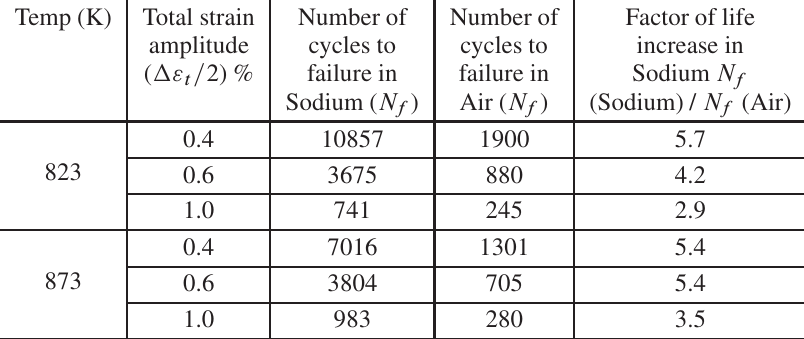
Table 2. LCF properties of 316L(N) Base Material in Sodium and Air